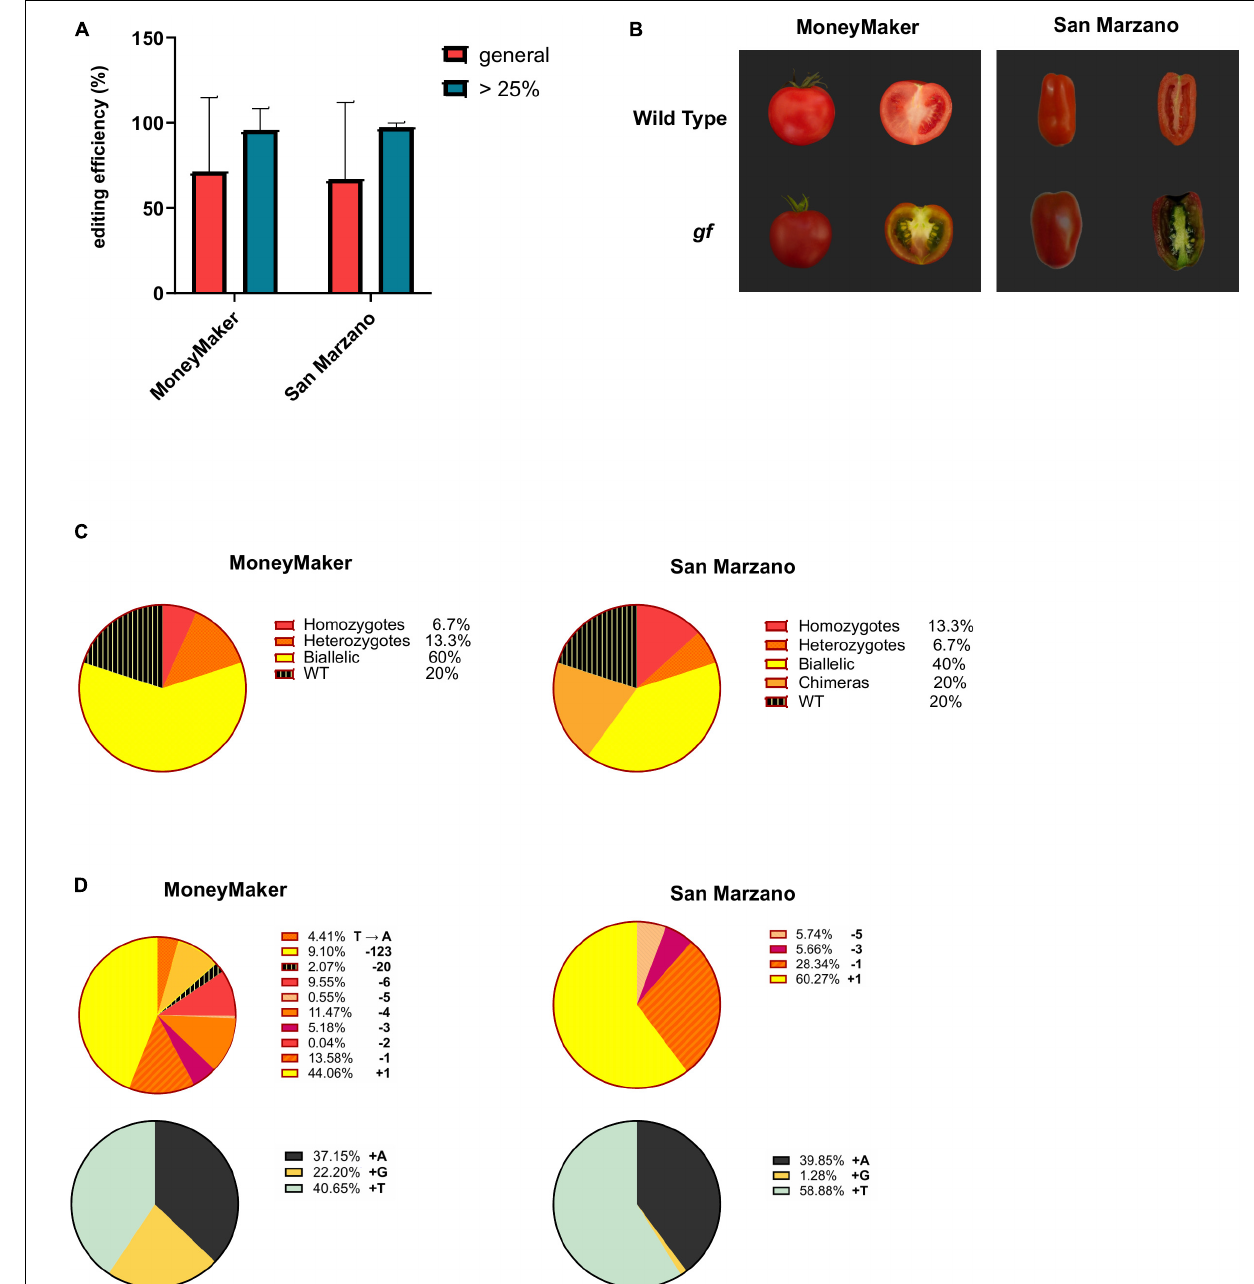
Frontiers in Plant Science |